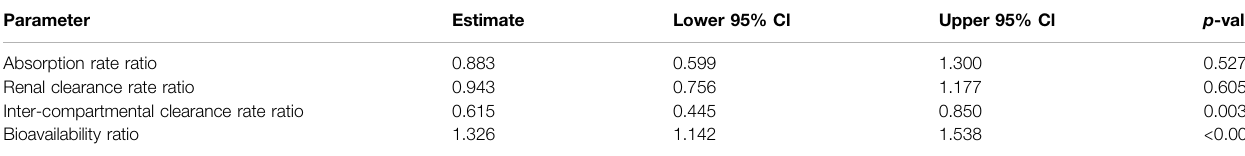
TABLE 3 | Two-compartment model parameter ratio estimates for radiation group, including 95% con fi dence interval bounds and p -values; fi tted to plasma + urine data. Parameter